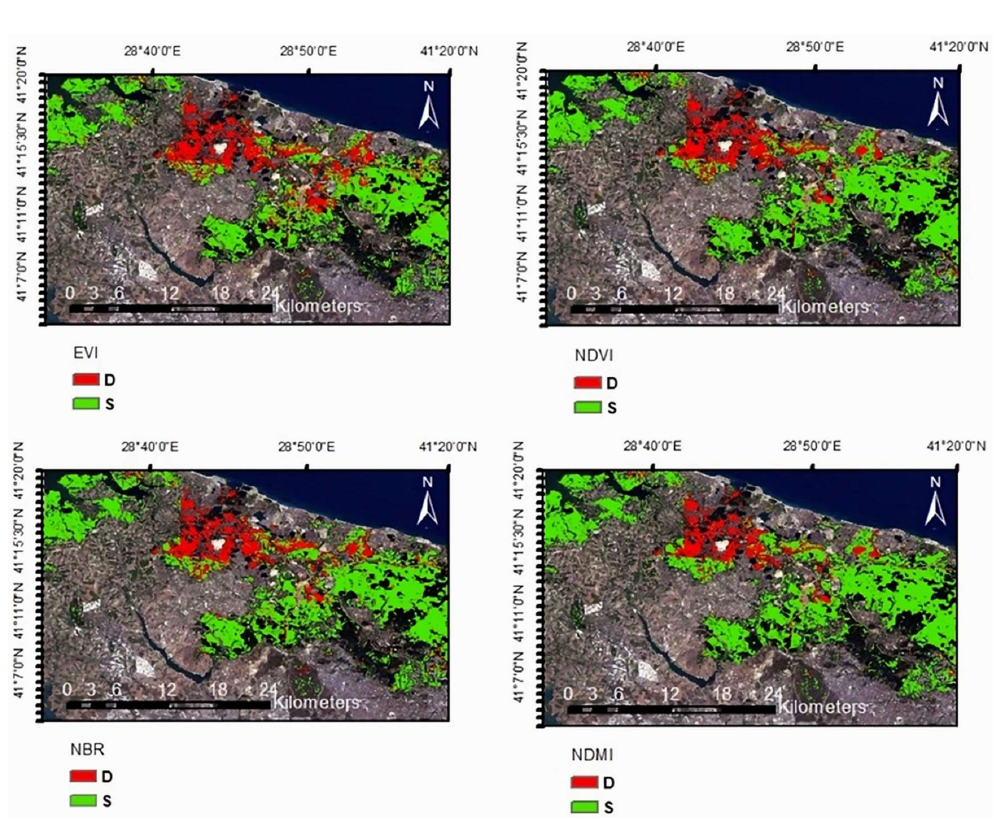
Figure 7. Demonstrating deforestation (D) and stable (S) spots in site A for all VIs.